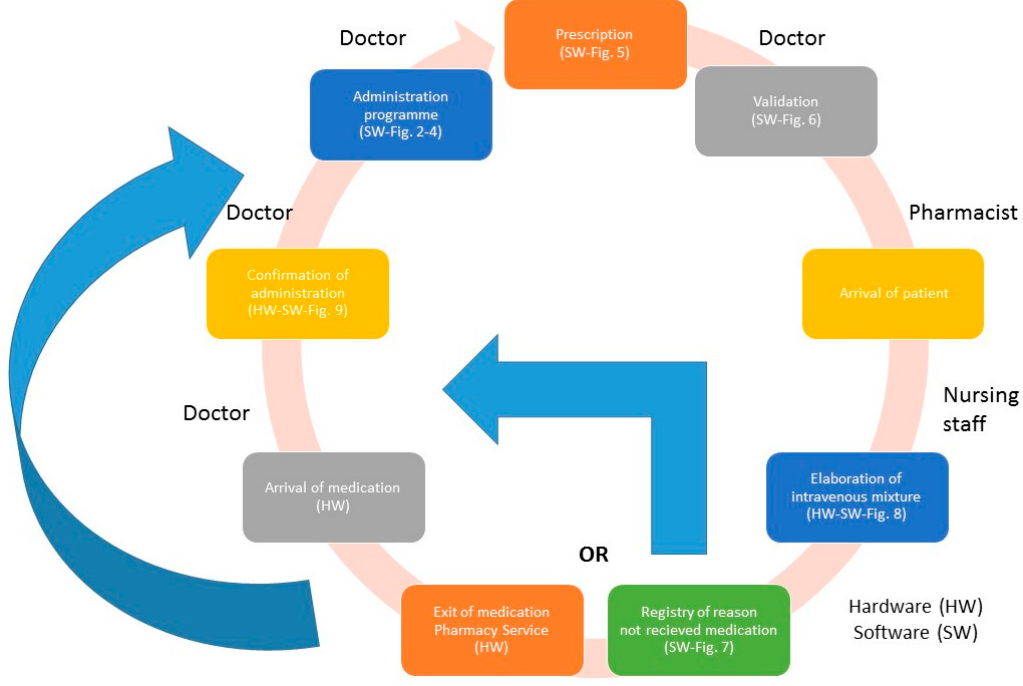
Figure 1. The process of prescription–validation–dosing–preparation–administration (PVD-PA) 1. The process of medication.